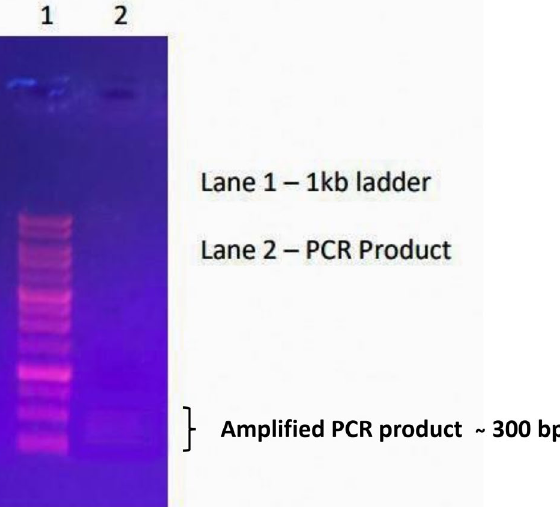
Figure 5. PCR amplified 18S rRNA gene smaller subunit partial sequence of the diatom Nitzschia palea at lane